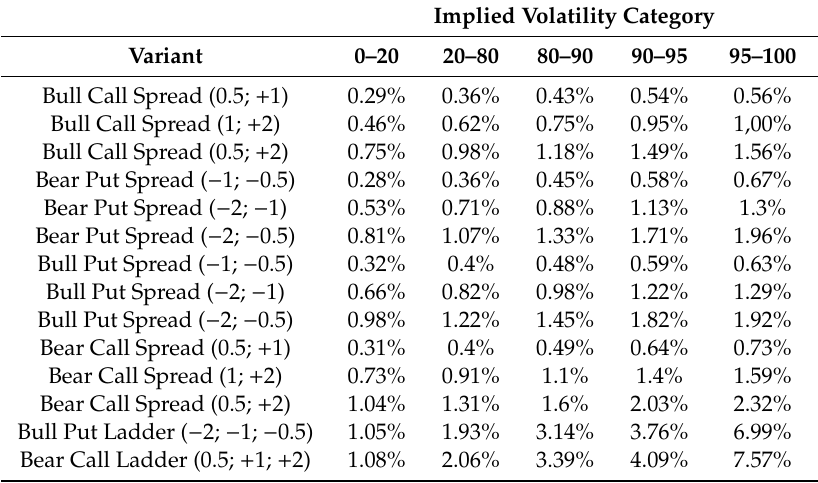
Table A2. Average cost (maximum loss) of vertical spreads for each category of implied volatility (% of one option